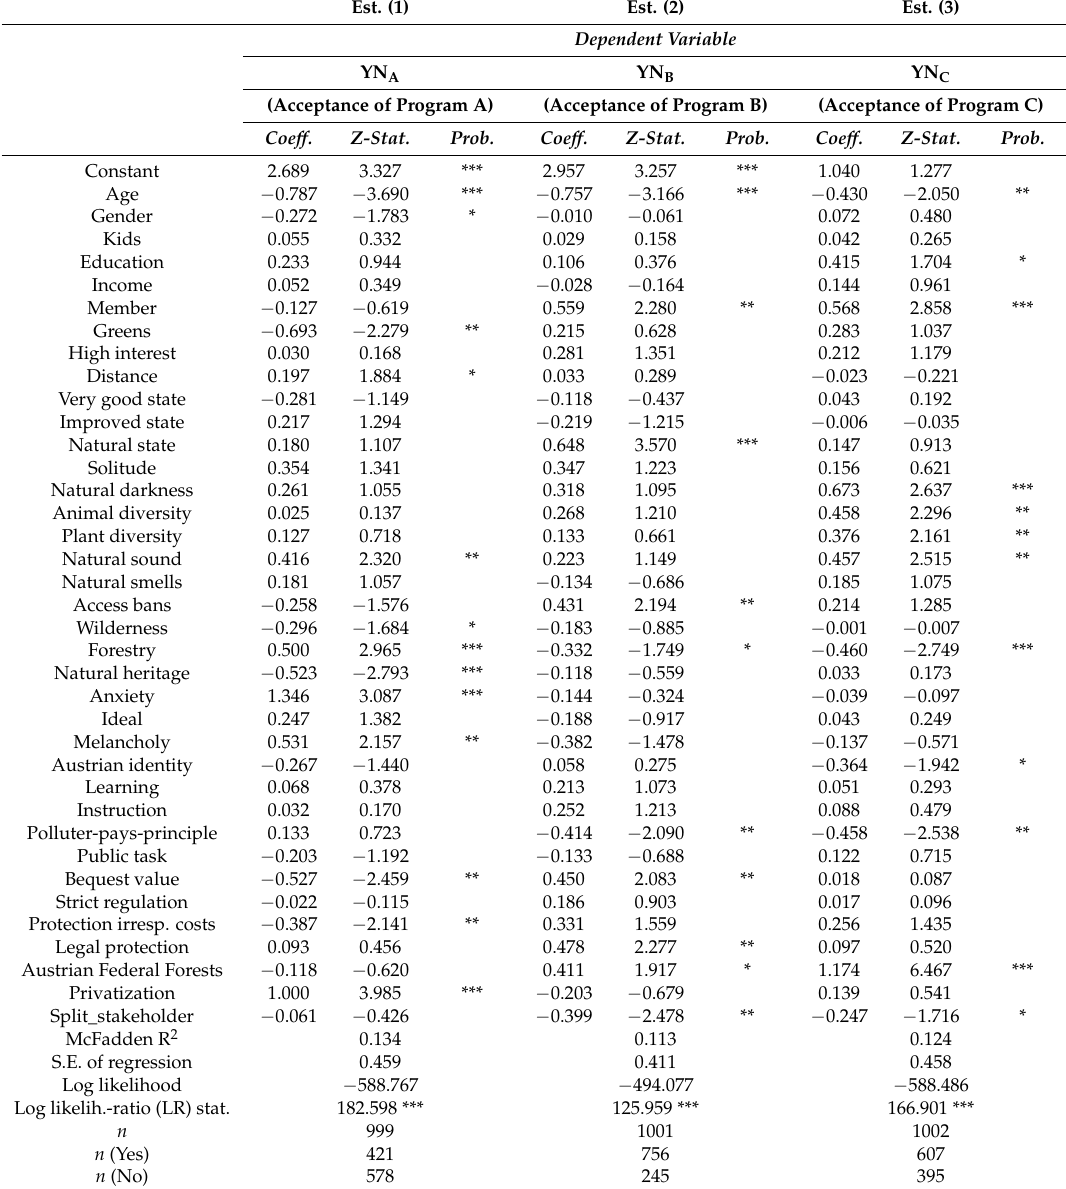
Table 4. Determinants of the respondents’ preferences for scenarios of forest and biodiversity development (computation by a standard binary logit estimation, maximum likelihood, extreme value; *** p < 0.01, ** p < 0.05, * p <